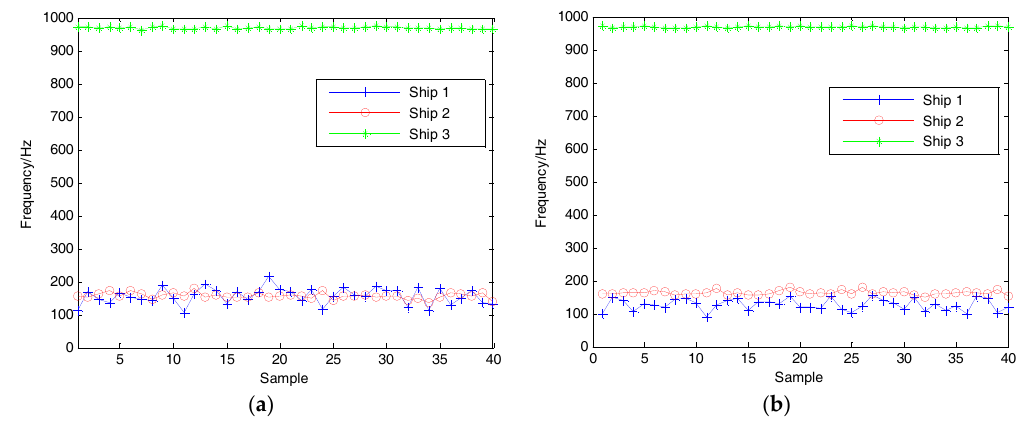
Figure 14. The center frequency of the IMF with the highest energy (EIMF). ( a ) without denoising; ( b ) after denoising.